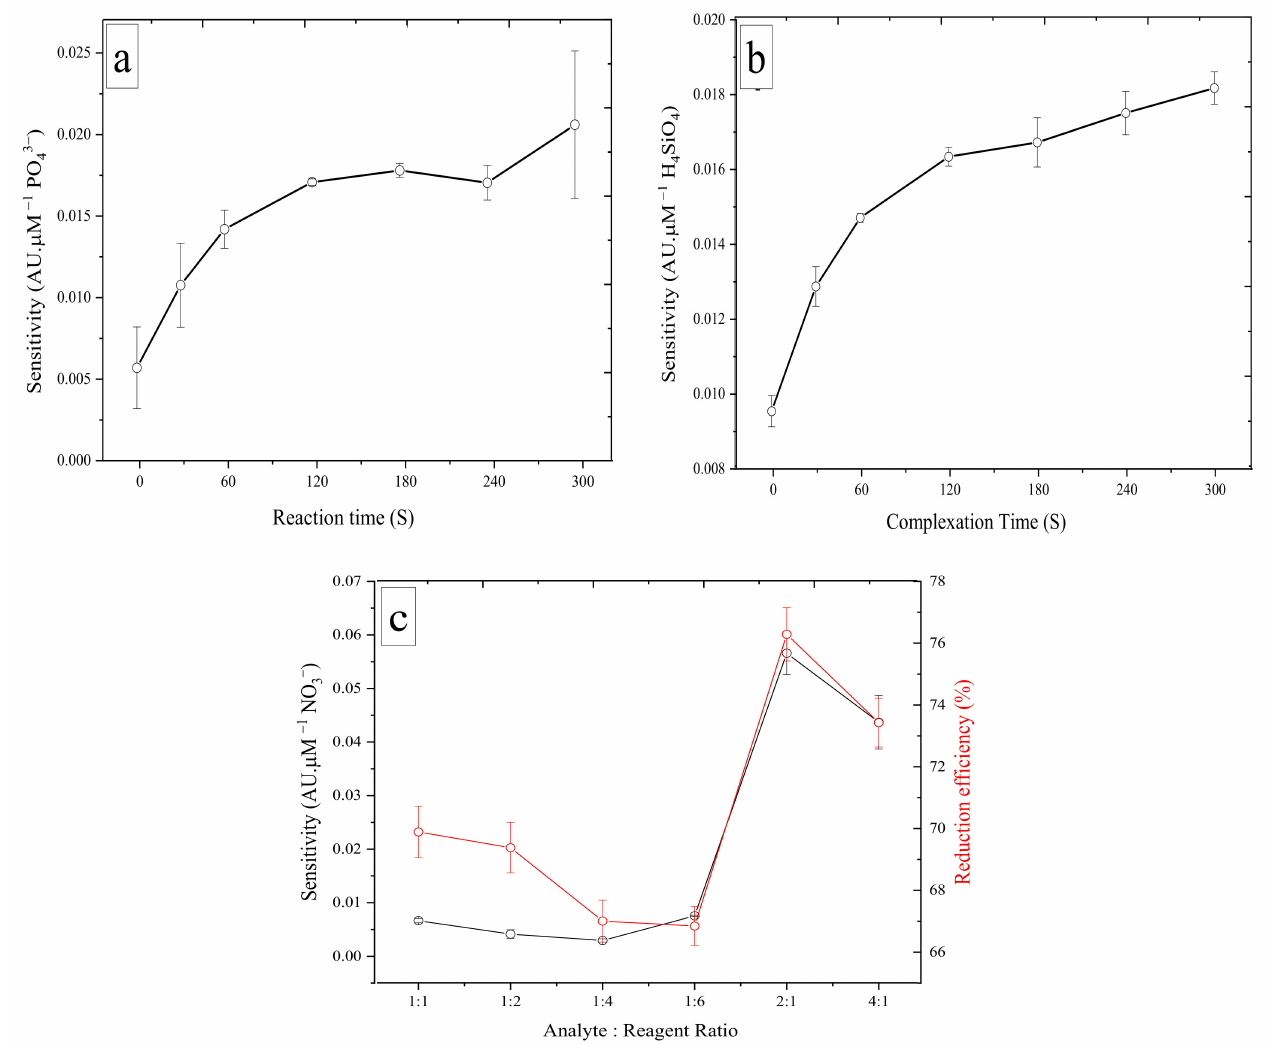
Figure 4. ( a ) Effect of the reaction time on the sensitivity (slope of the calibration curve: 0, 1, 2 µ M PO 4 3 − ). ( b ) Effect of the complexation time on the sensitivity (slope of the calibration curve: 0, 1, 2 µ M Si). ( c ) Effect of changing the analyte: reagent ratio on the sensitivity of the calibration curve (0, 1, 2 µ M NO 3 − ) (black lines) and on the reduction efficiency (%) (red lines). AU: absorbance unit. Error bar ( ± 1 SD), n =